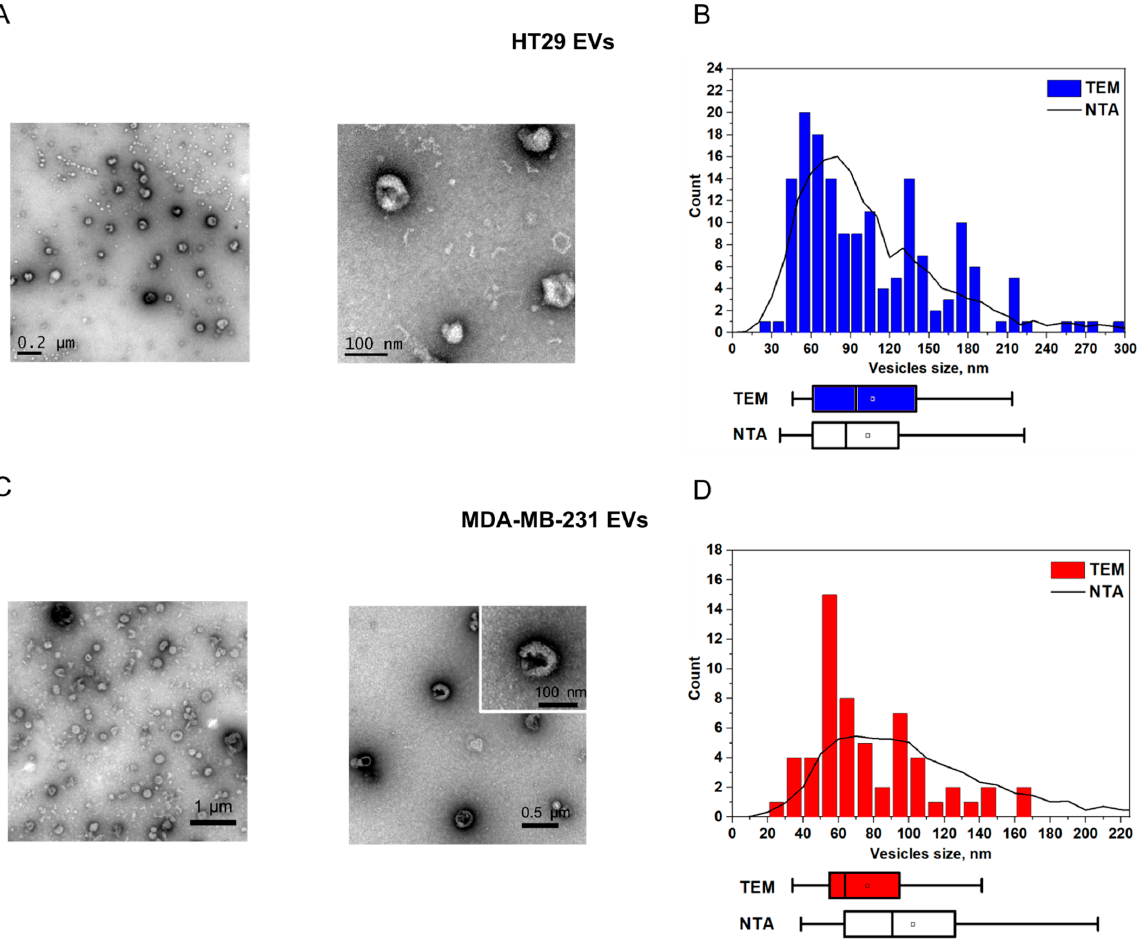
Figure 2. Characterization of EVs purified from HT29 and MDA MB-231 cell culture supernatants. ( A , C ) TEM images and ( B , D ) corresponding NTA/TEM particle size distributions. The squares indicate mean values, while the box-and-whisker plots show 5%, 25%, 50%, 75%, and 95% percentiles.